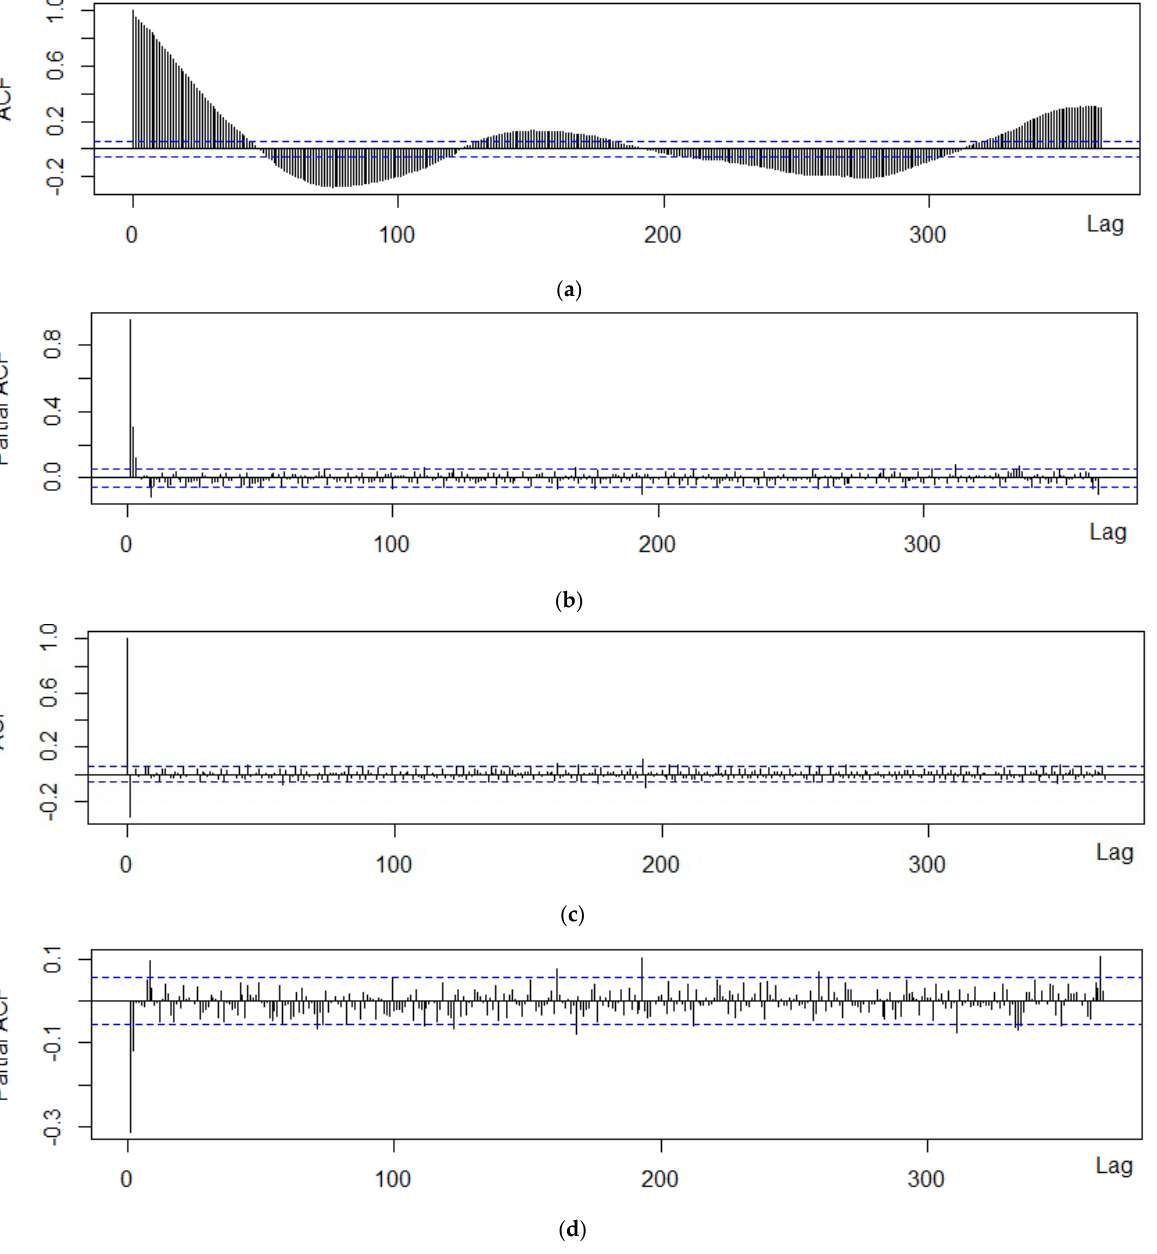
Figure 3. Autocorrelation function (ACF) of the Moran’s I b for Potatoes prices for original time series ( a ) and for the first differences ( c ); partial autocorrelation function (PACF) of the Moran’s I b for Potatoes prices for original time series ( b ) and for the first differences ( d ).